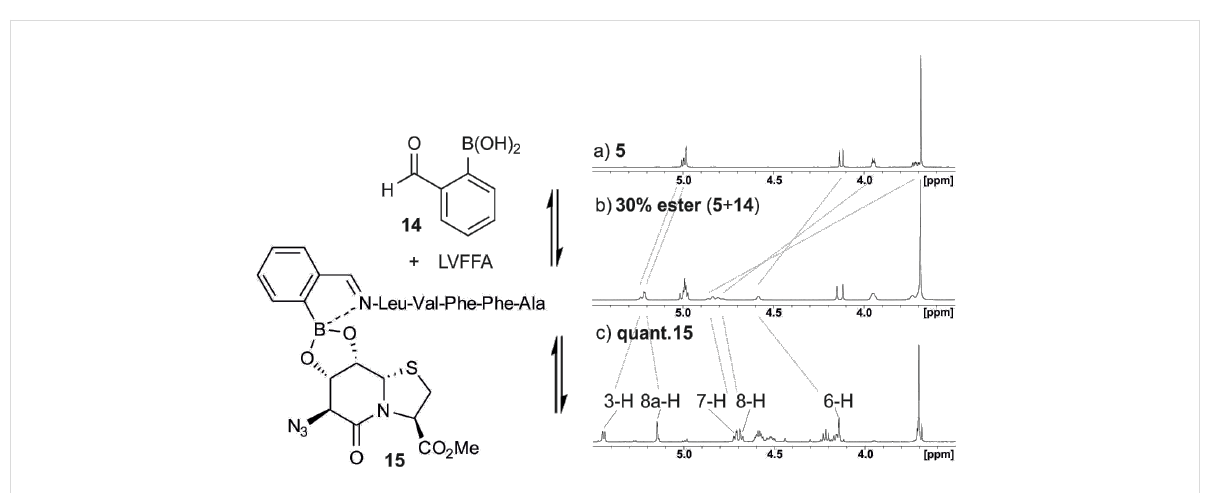
Figure 8: Template 5 ( 1 H NMR expansion shown for reference DMSO- d 6 , 300 K) and peptide Leu-Val-Phe-Phe-Ala are linked by 2-formylphenyl- boronic acid ( 14 ) in an NMR experiment (DMSO- d 6 , 300 K). The esterification of 5 with boronic acid is incomplete and stops at 30% conversion. The addition of the peptide which forms the imine drives the esterification to completion ( 15 ).